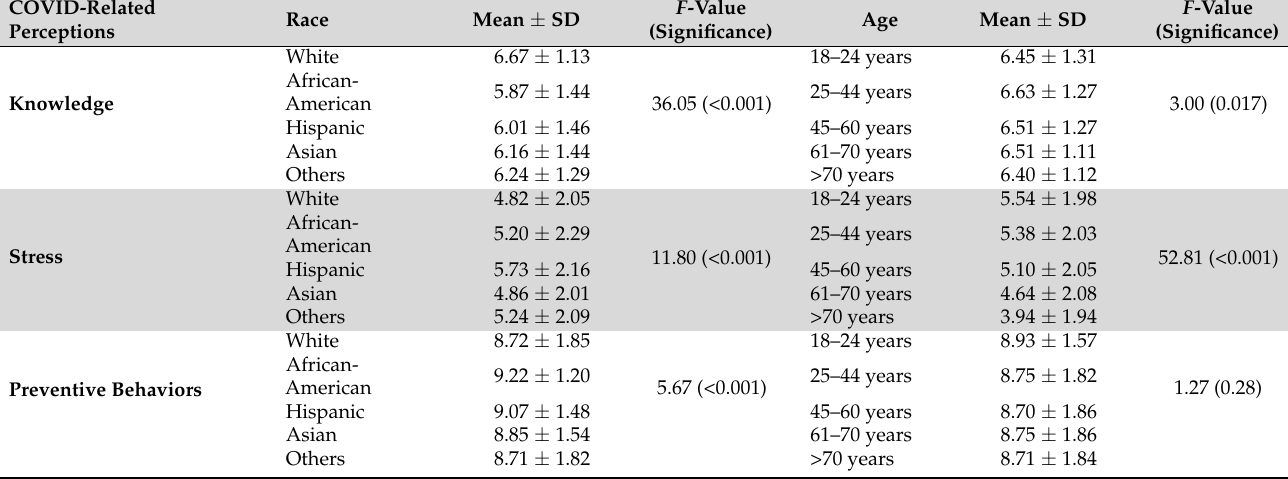
Table 2. The difference in preventive behaviors, knowledge, and stress among various races and age-groups. The level of significance was estimated by